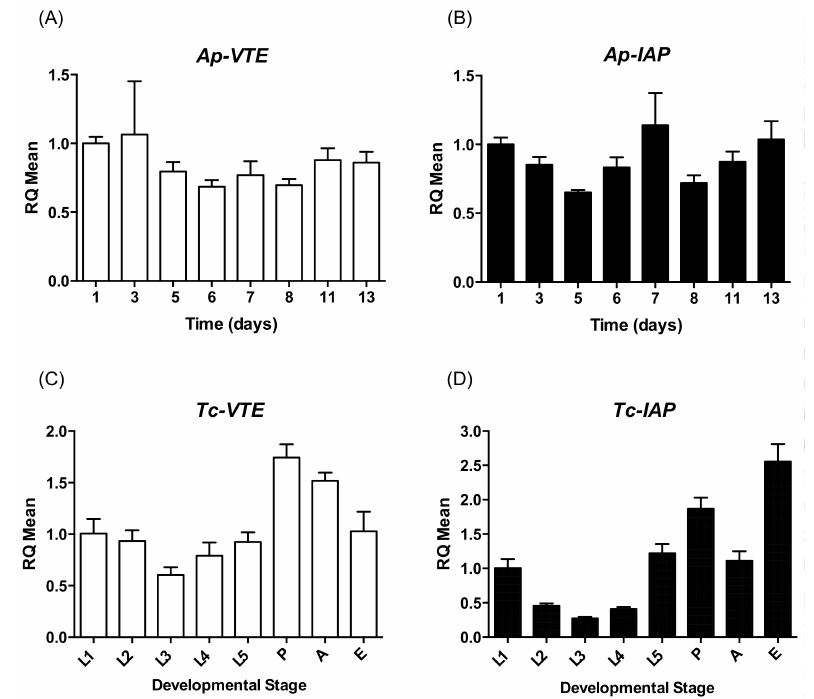
Figure 1. Expression of V-ATPase subunit E ( VTE , shown in white column) and inhibitor of apoptosis ( IAP , shown in black column) genes throughout the life cycle of ( A , B ) A. pisum ( Ap ) and ( C , D ) T. castaneum ( Tc ) by quantitative PCR. For Ap , day 1 corresponds to the nymphal stage with analysis following development at days specified until the onset of nymph production at day 13. Developmental stages for Tc are L1 = 1st–2nd instar, L2 = 2nd–3rd instar, L3 = 3rd–4th instar, L4 = 4th–5th instar, L5 = 5th–6th instar (pre-pupal stage), P = pupa, A = adult, E = egg. RQ set to 1.0 for Day 1 or L1 samples. Error bars depict ± SD of the mean for 3 technical replicates ( n = 5 insects or 30 mg eggs per